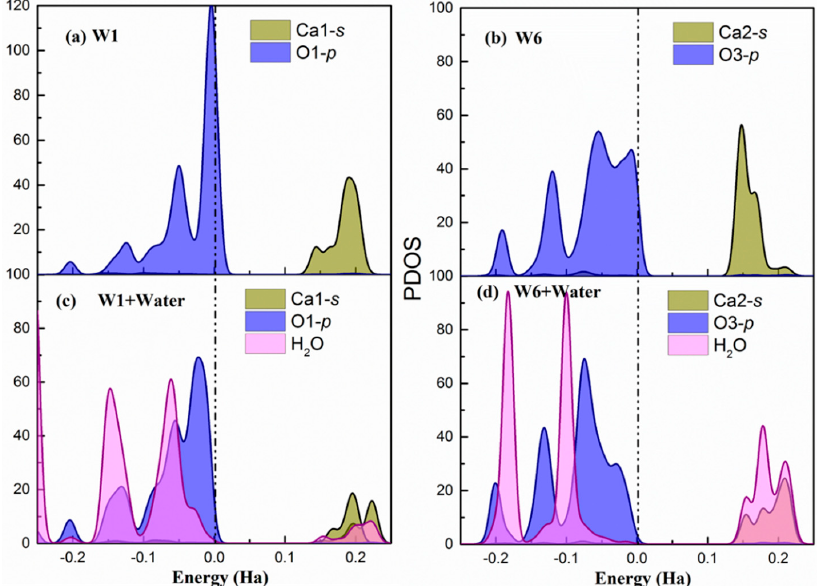
Figure A3. Surface (010) ( a , b ) The partial density of states of W1 and W6 adsorption sites on the relaxed surface. ( c , d ) The partial density of states of W1 and W6 adsorption sites after being water adsorbed on the surface. The dash dot line indicates the Fermi level.